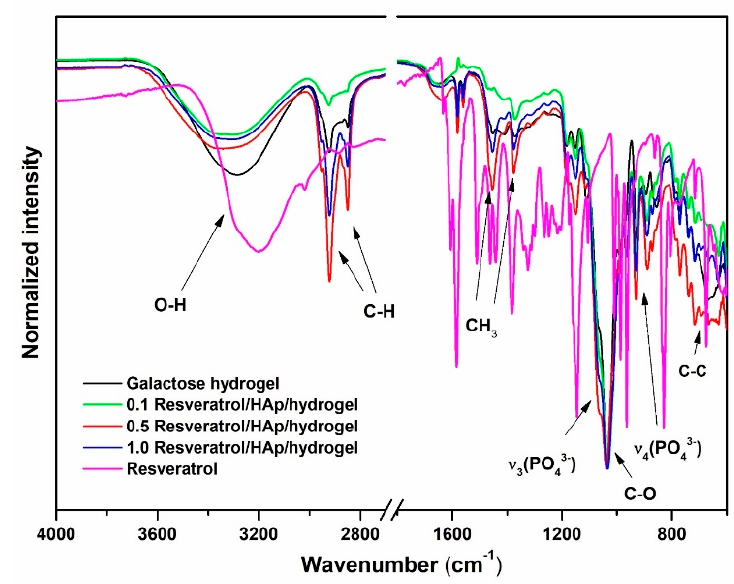
Figure 5. IR spectra of resveratrol, galactose hydrogel, 0.1 resveratrol/nHAp/hydrogel, 0.5 resveratrol/nHAp/hydrogel, and 1.0 resveratrol/nHAp/hydrogel.